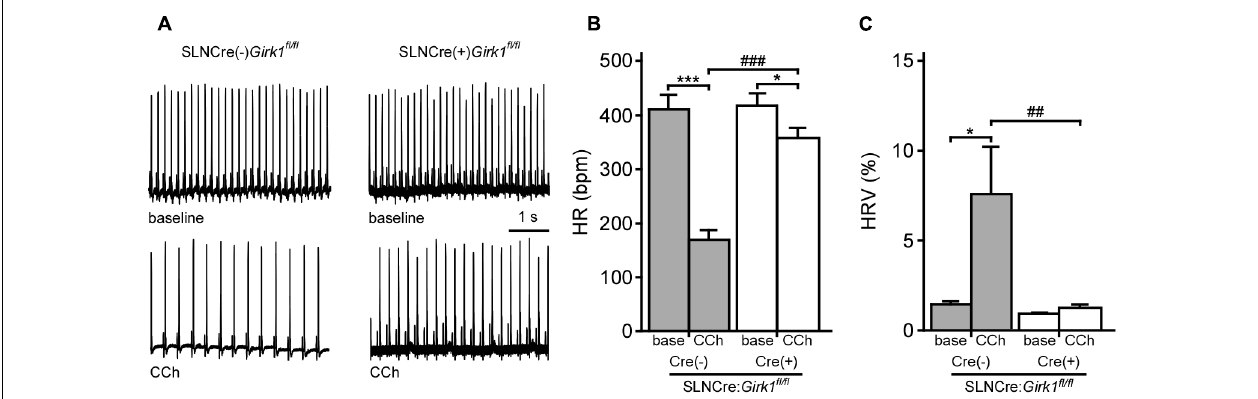
FIGURE 2 | Impact of atrial GIRK channel ablation on HR and HRV responses to carbachol. (A) Representative segments of ECG recordings from anesthetized SLNCre(–): Girk1 fl / fl and SLNCre(+): Girk1 fl / fl mice, at baseline (Top) and following administration of CCh (1.0 mg/kg IP; Bottom). (B) Summary of HR data at baseline (base) and after CCh injection for SLNCre(–): Girk1 fl / fl ( n = 7) and SLNCre(+): Girk1 fl / fl ( n = 8) mice. Two-way ANOVA analysis revealed an interaction between genotype and treatment ( F 1 , 13 = 38.6; P < 0.001). Symbols: ∗ P < 0.05 and ∗∗∗ P < 0.001, vs. baseline (within genotype); ### P < 0.001 vs. SLNCre(–): Girk1 fl / fl (within treatment). (C) Summary of HRV data at baseline (base) and after CCh injection for SLNCre(–): Girk1 fl / fl ( n = 7) and SLNCre(+): Girk1 fl / fl ( n = 8) mice. HRV